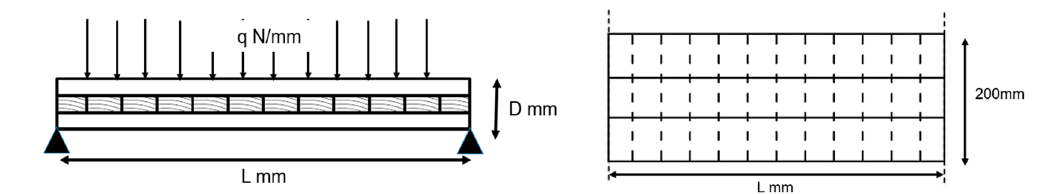
Figure 3. Geometric dimensions of the simply supported CLT models. Table 1. Elastic constants for orthotropic and transversely isotropic material